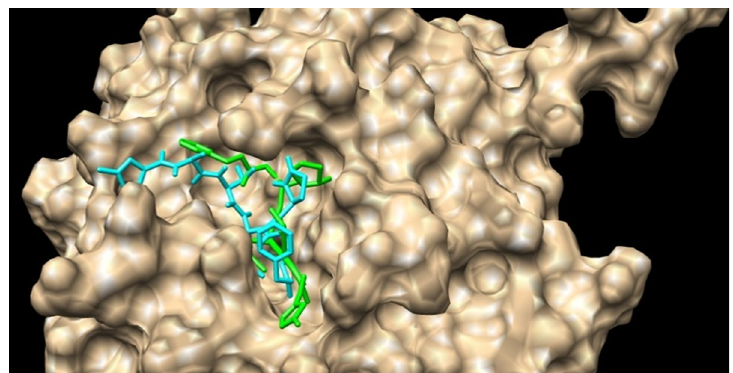
Fig 4. Binding pose of N3 inhibitor: Docked (green) co-crystallized (cyan) at the active site of the SARS-CoV-2Mpro (superimposed structures).